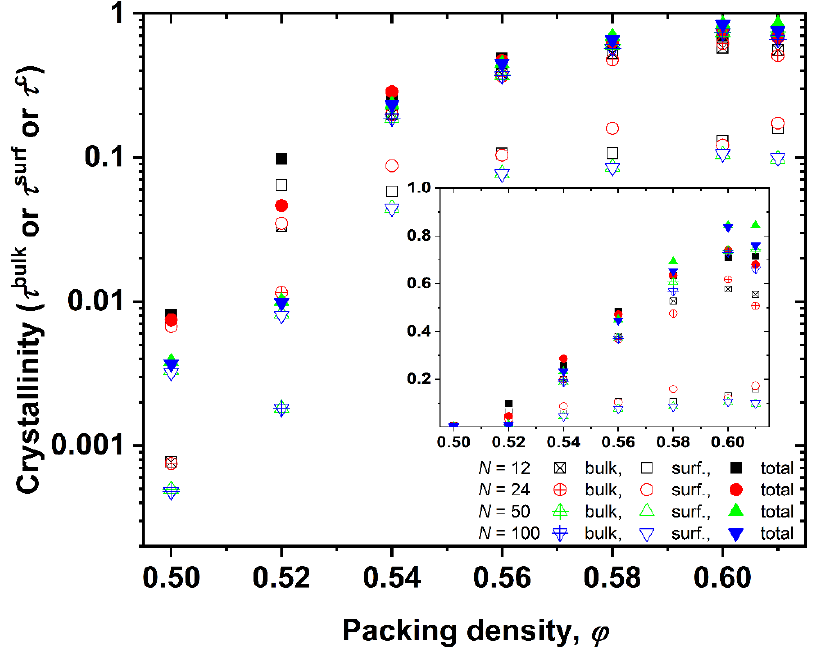
Figure 5. Linear-log plot of the dependence of bulk ( τ bulk ), surface ( τ surf ), and total ( τ c ) crystallinity on the packing density, ϕ , for all simulated systems. Inset: same but in a linear-linear plot.